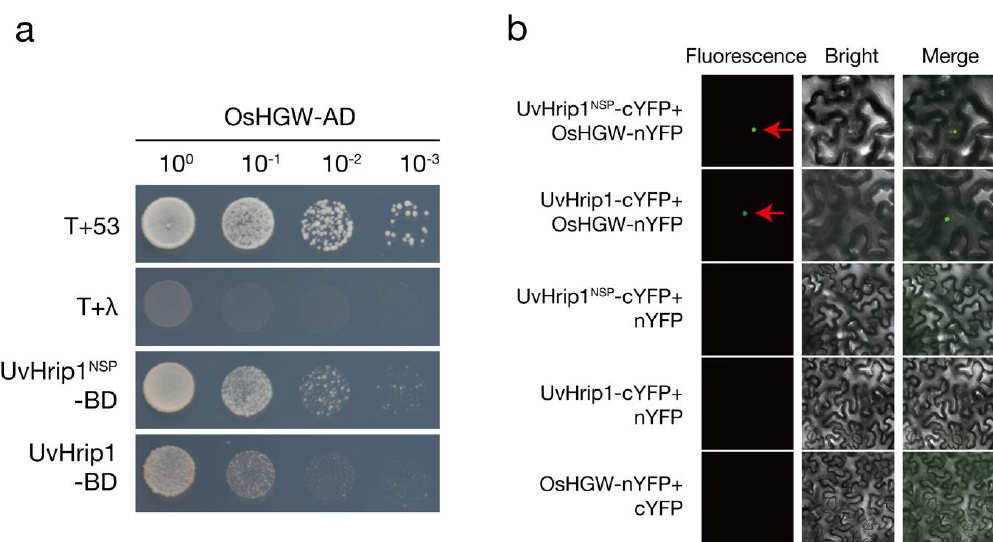
Figure 3. The subcellular localization of UvHrip1-GFP and UvHrip1 NSP -GFP. UvHrip1-GFP and UvHrip1 NSP -GFP were transiently expressed in rice protoplasts. The green fluorescence of UvHrip1-GFP and UvHrip1 NSP -GFP was detected in the nuclei and cytoplasm of rice cells, respectively. The vector pUC19 carrying gfp driven by 35S promoter was used as a control. The photos were taken under a laser scanning confocal microscopy 16–20 h after transformation. The red and yellow arrows indicated nuclei and cytoplasm, respectively.